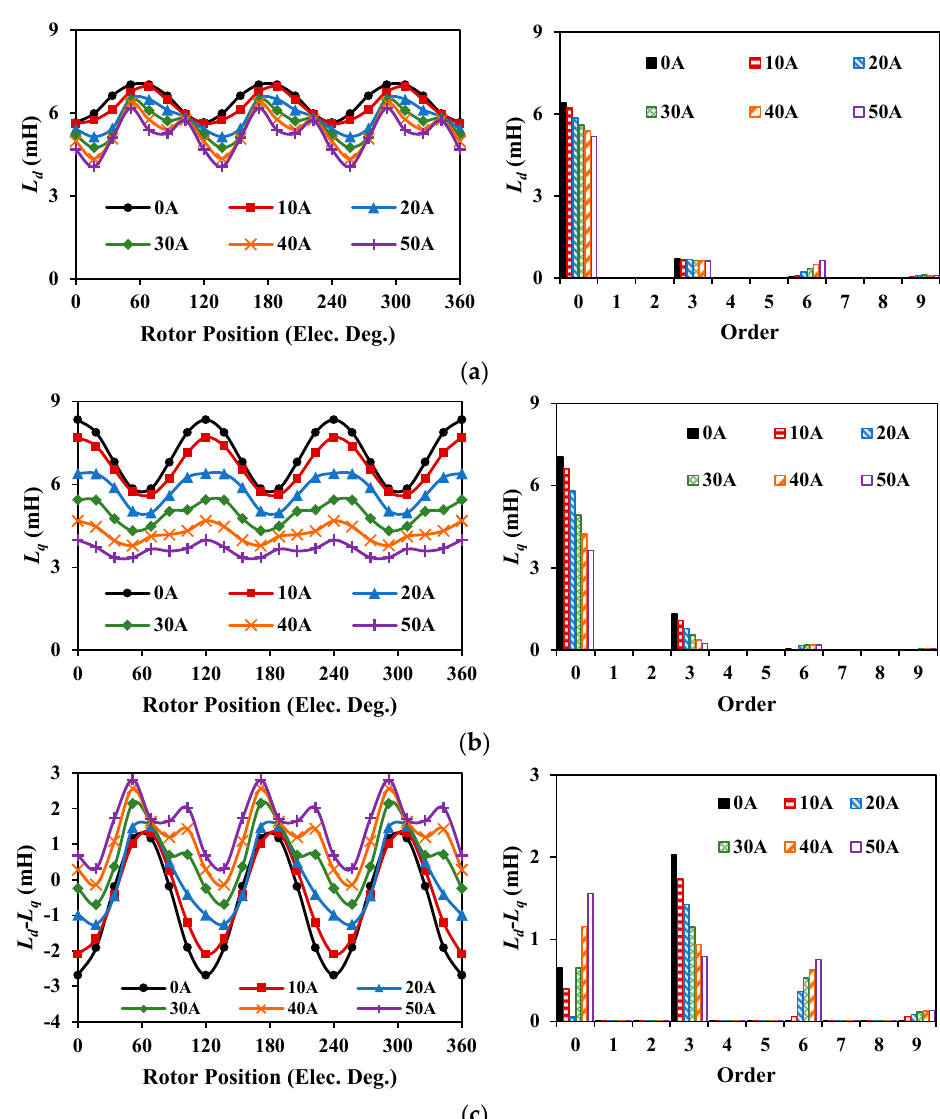
Figure 17. Inductances and spectra for 12s8p CCPPM machine. ( a ) L d . ( b ) L q . ( c ) L d - L q . Commonly, a higher armature reaction tends to result in higher pulsation in inductance, which can be seen in the amplitudes of 6th order harmonics in L d and L q for all the machines. However, the dominant 3rd order harmonics for 12s8p-CCPPM machine are smaller with the current increase, which leads to its decreasing trend of the overall fluctuation in inductance waveforms. This is because the saturation in iron pole can reduce the unbalance permeability between PM and iron poles in the rotor, which is the source of the dominant third-order harmonics in L d and L q [12]. Consequently, the overall fluctuation in differences between L d and L q for 12s8p-CCPPM machine shows a decreasing trend while an increasing trend can be seen in other machines. However, the reluctance torque is proportional to the square of the current. Therefore, the overall reluctance torque ripple still shows a rising trend with the current ( a )